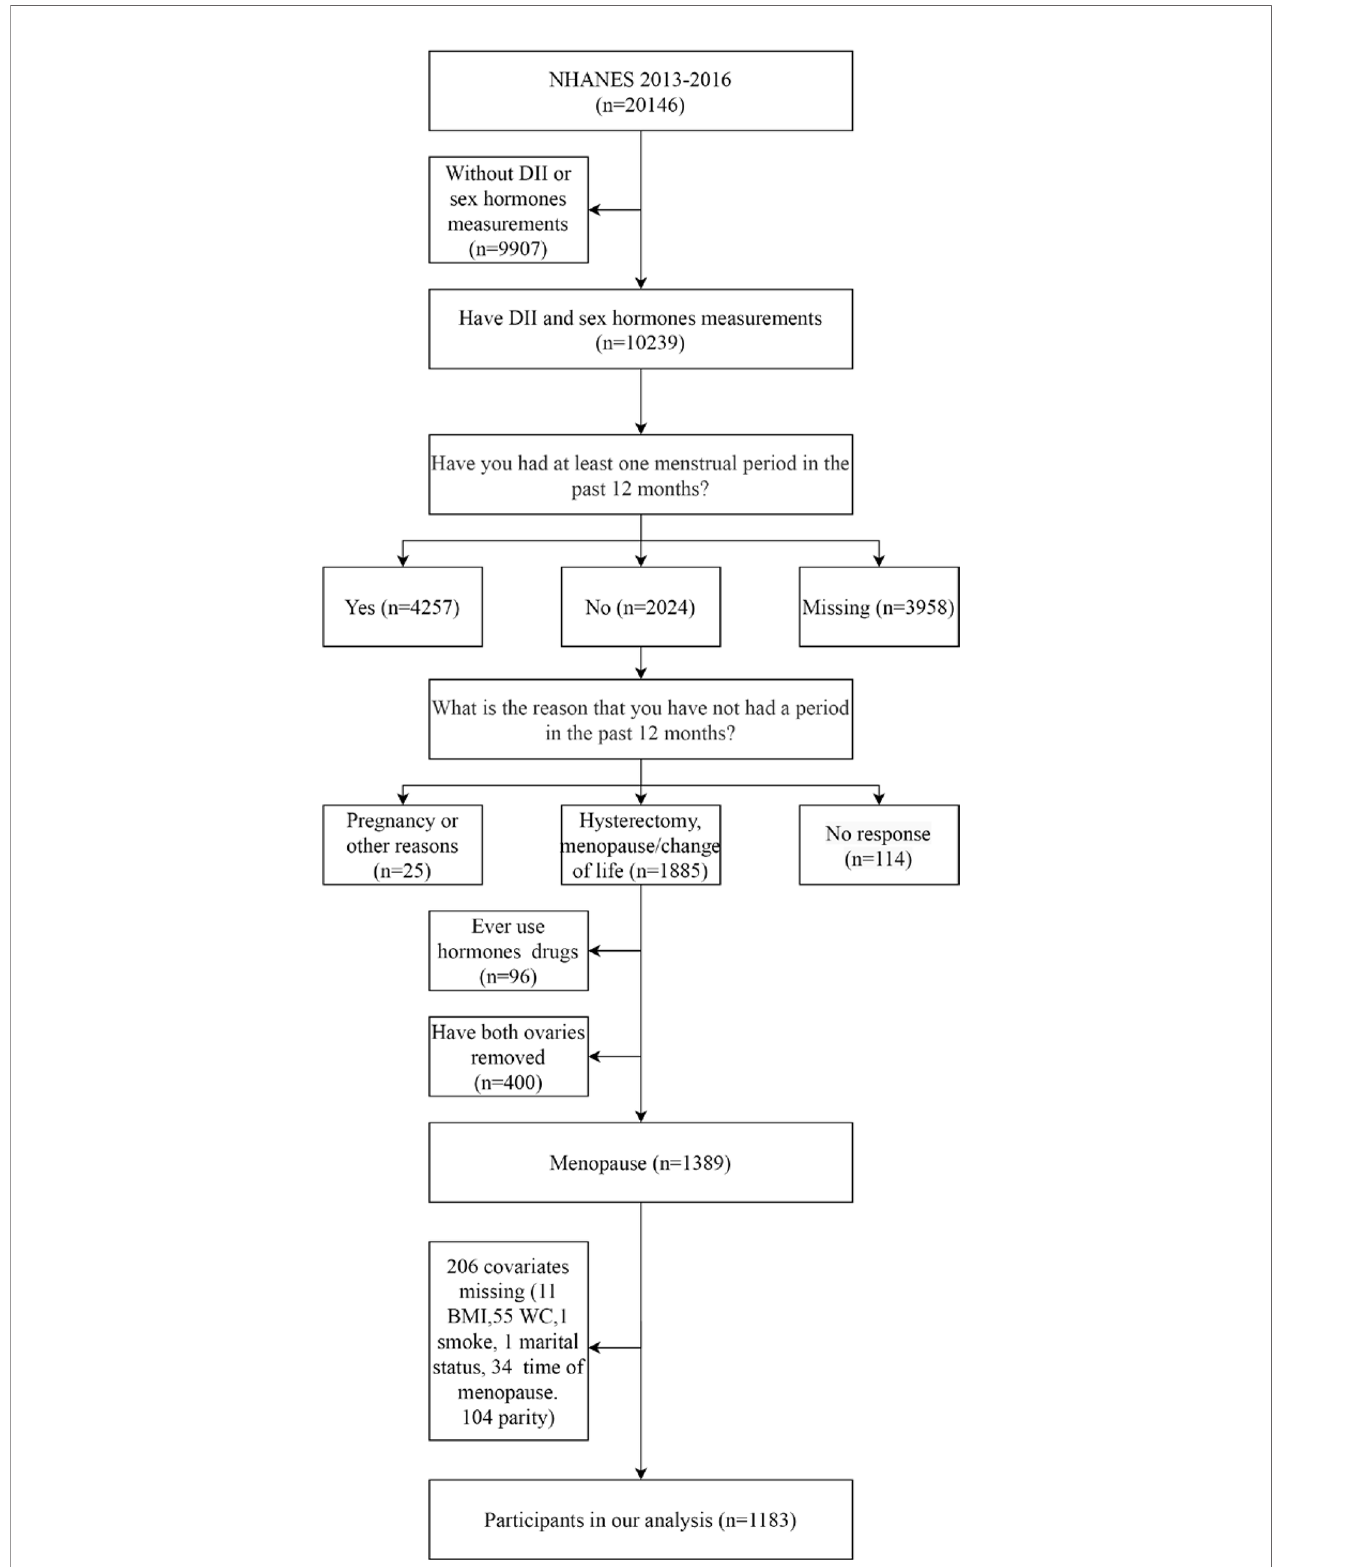
FIGURE 1 | Flow chart of the selection of the study